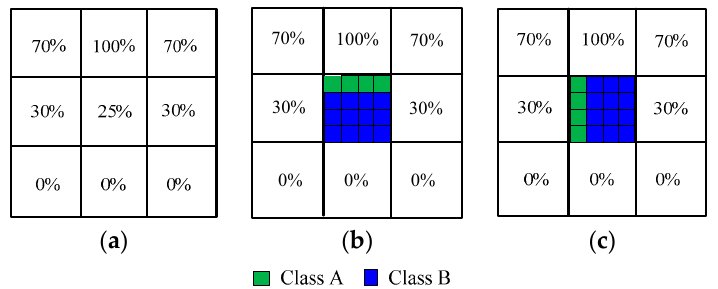
Figure 1. Example of spatial correlation. ( a ) Spectral unmixing result of Class A. ( b ) Probability of Distribution 1. ( c ) Probability of Distribution 2.